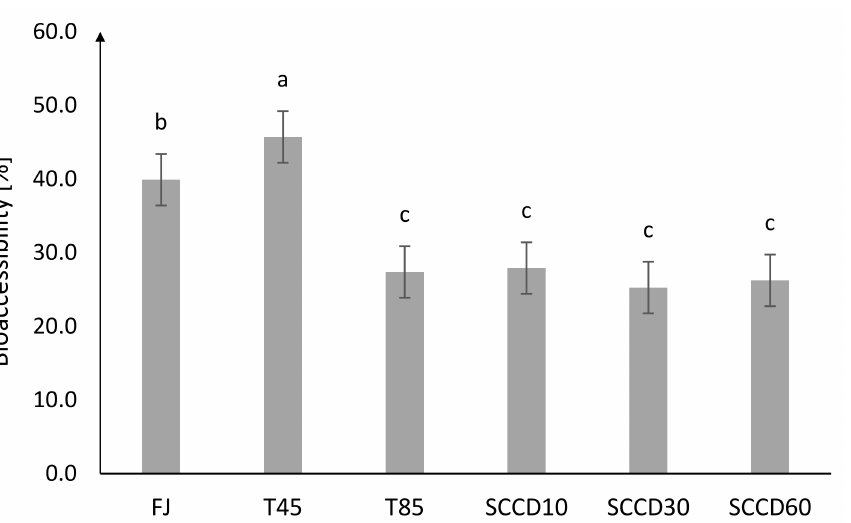
Figure 2. Bioaccessibility of total vitamin C in the dialysate after different processing: FJ-fresh juice; T45-thermal treated juice at 45 ◦ C; T85-thermal treated juice at 85 ◦ C; SCCD10-juice after supercritical carbon dioxide treatment at 10 MPa; SCCD30-juice after supercritical carbon dioxide treatment at 30 MPa; SCCD60-juice after supercritical carbon dioxide treatment at 60 MPa (The same letter above the bars indicates no significant difference between the mean ( p ≤ 0.05) bioaccessibility of the samples after the different type of